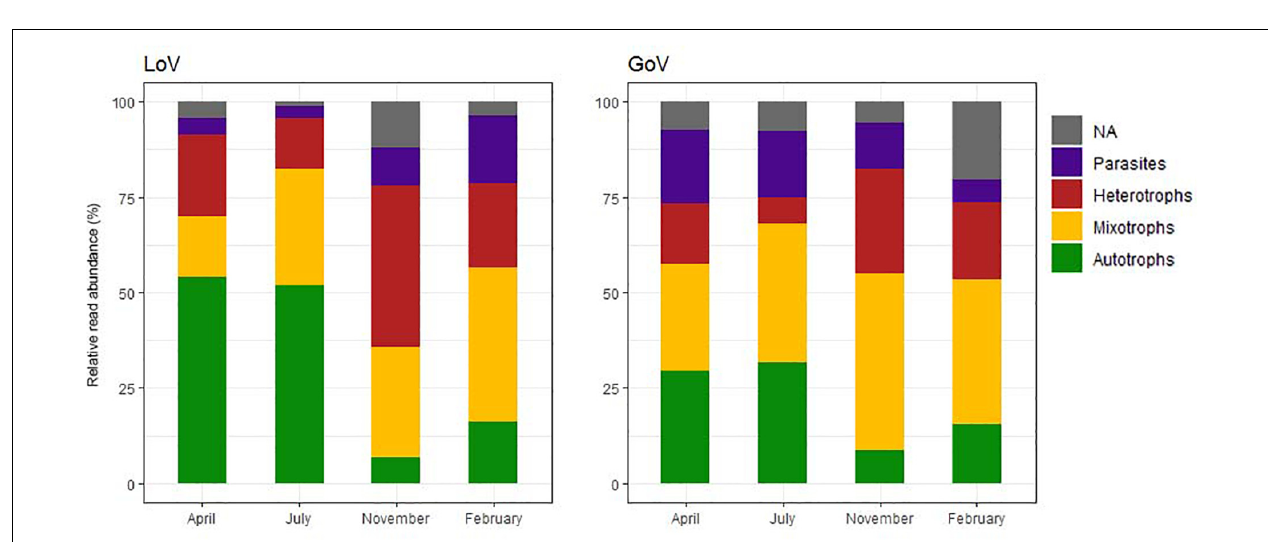
FIGURE 4 | Temporal variations of the relative abundance of the trophic groups in the Lagoon (LoV) and in the Gulf of Venice (GoV) based on the whole normalized dataset (NA, not